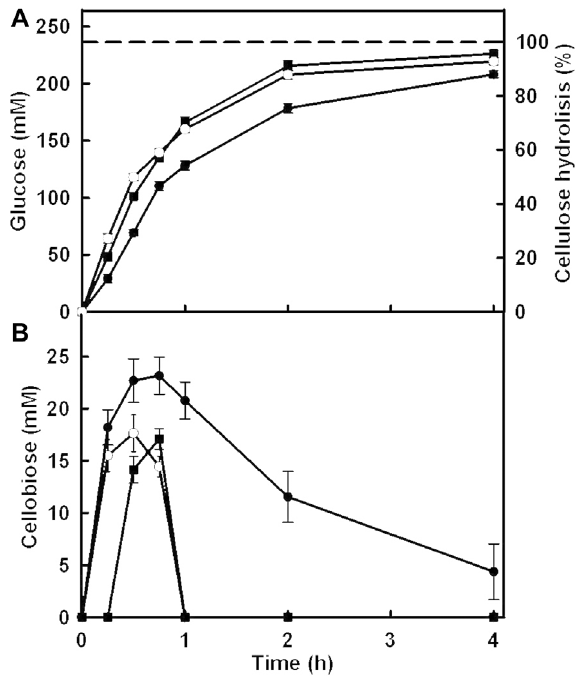
Figure 4 Time course profiles of glucose (A) and cellobiose (B) release during the enzymatic hydrolysis of regenerated cellulose (RC) (40 mg/ml) according to different cellulase:cellobiase ratios (2:1 ●, 1:6 ■, 1:3.5